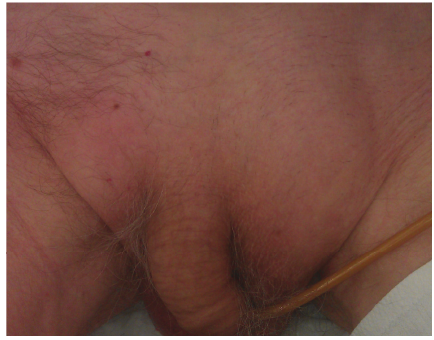
Figure 1: An irreducible, nontender mass in the left groin.